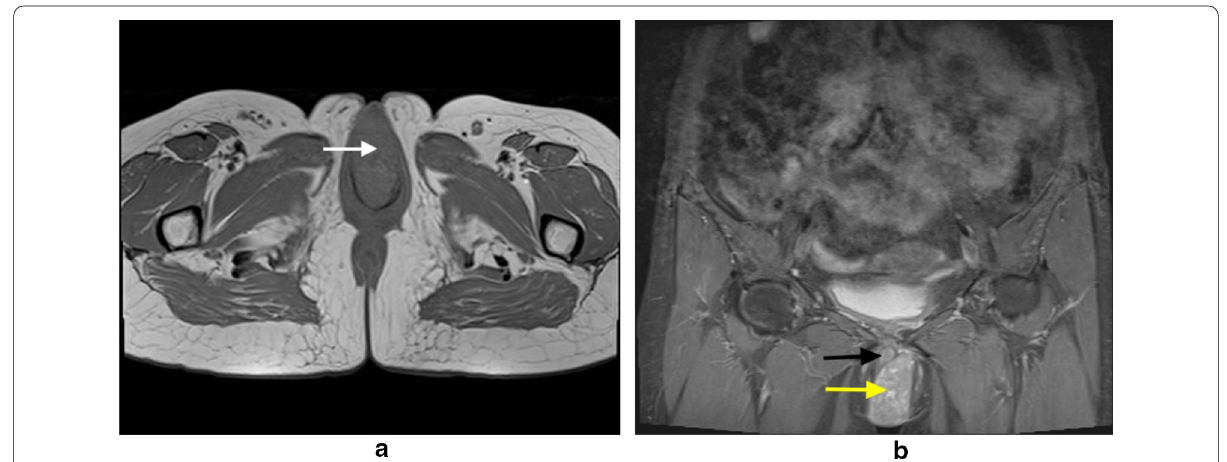
Fig. 2 Pelvic MRI T1-weighted images a Axial scan showing isointense mass b Coronal scan showing contrast enhancement of mass (yellow arrow), posterolateral to urethra (black